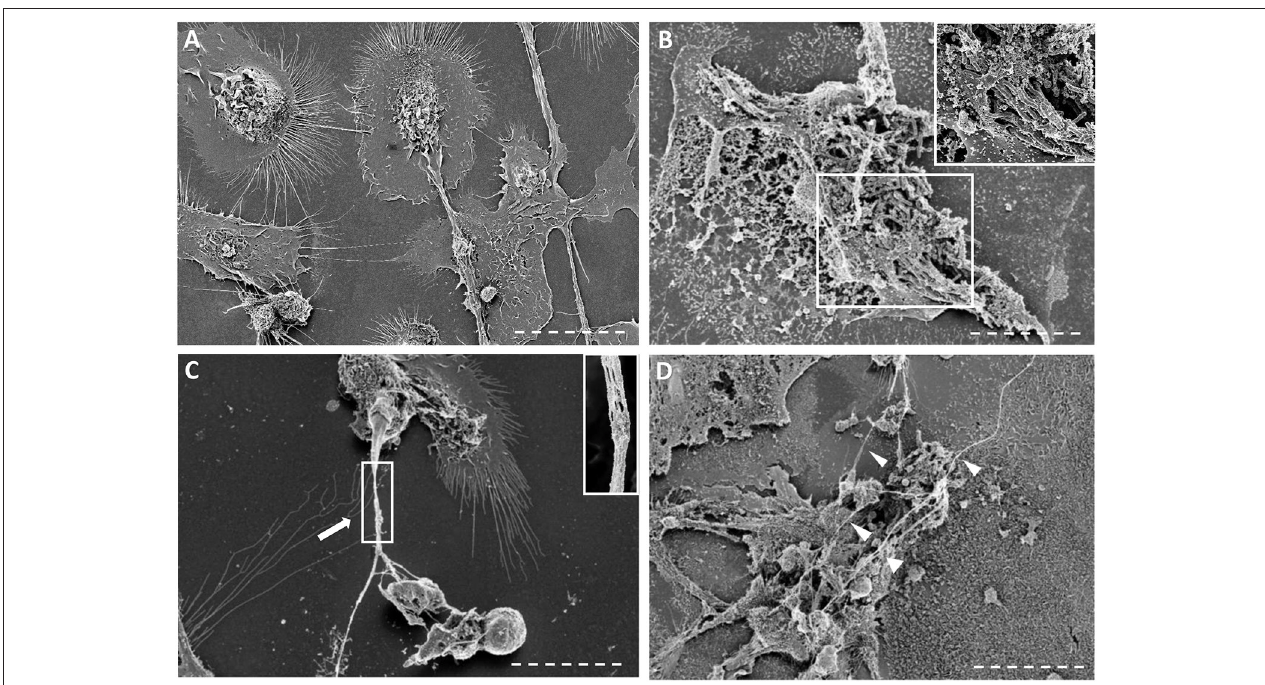
FIGURE 3 | Scanning electron microscopy images of macrophages infected with non-cording or cording cultures. (A–D) Scanning micrographs of cells fixed with glutaraldehyde after 24 h of infection either with (A) non-cording bacteria or (B–D) cording bacteria. METs formed by human macrophages are either (C) in form of threads or (D) meshwork. The white arrows indicate the thread of DNA while the arrow heads show the meshwork. Bar: 10 µ m